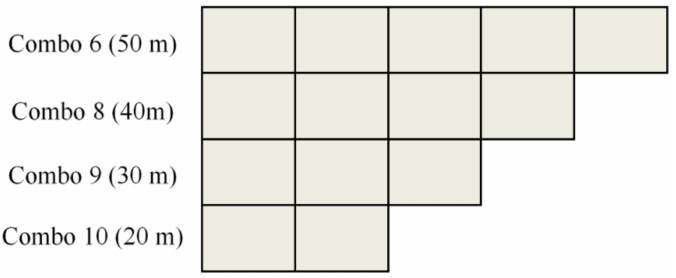
Figure 12. Pipe length of the combos compared in the fifth step.